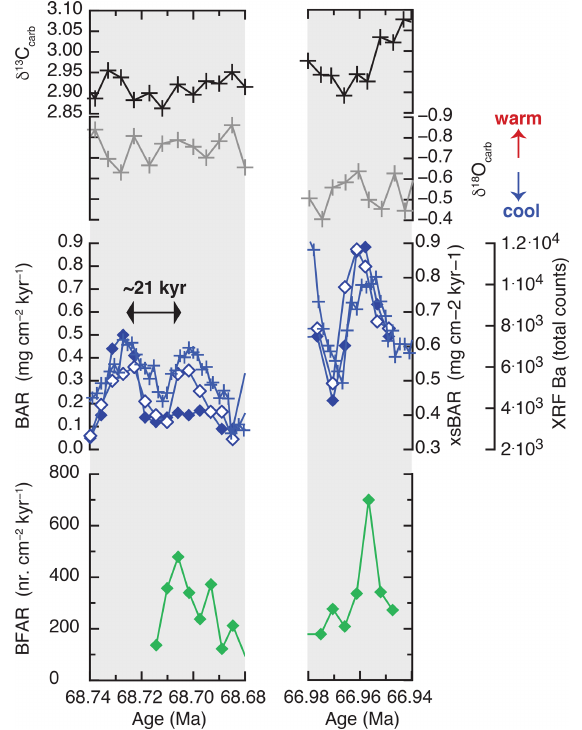
Figure 6. Two discrete sample intervals covering potential cycles of precession ( ∼ 21kyr) with surface-water-related proxies (bulk δ 13 C, δ 18 O), organic carbon export proxies (scanning XRF Ba: crosses; excess-BaAR: open diamonds; and BAR: solid diamonds), and proxy for organic carbon arrival at the seafloor (BFAR: green diamonds). A positive correspondence is seen between carbon ex- port from the surface of the oceans (XRF Ba, excess-BaAR, BAR) and organic carbon arrival at the seafloor (BFAR).